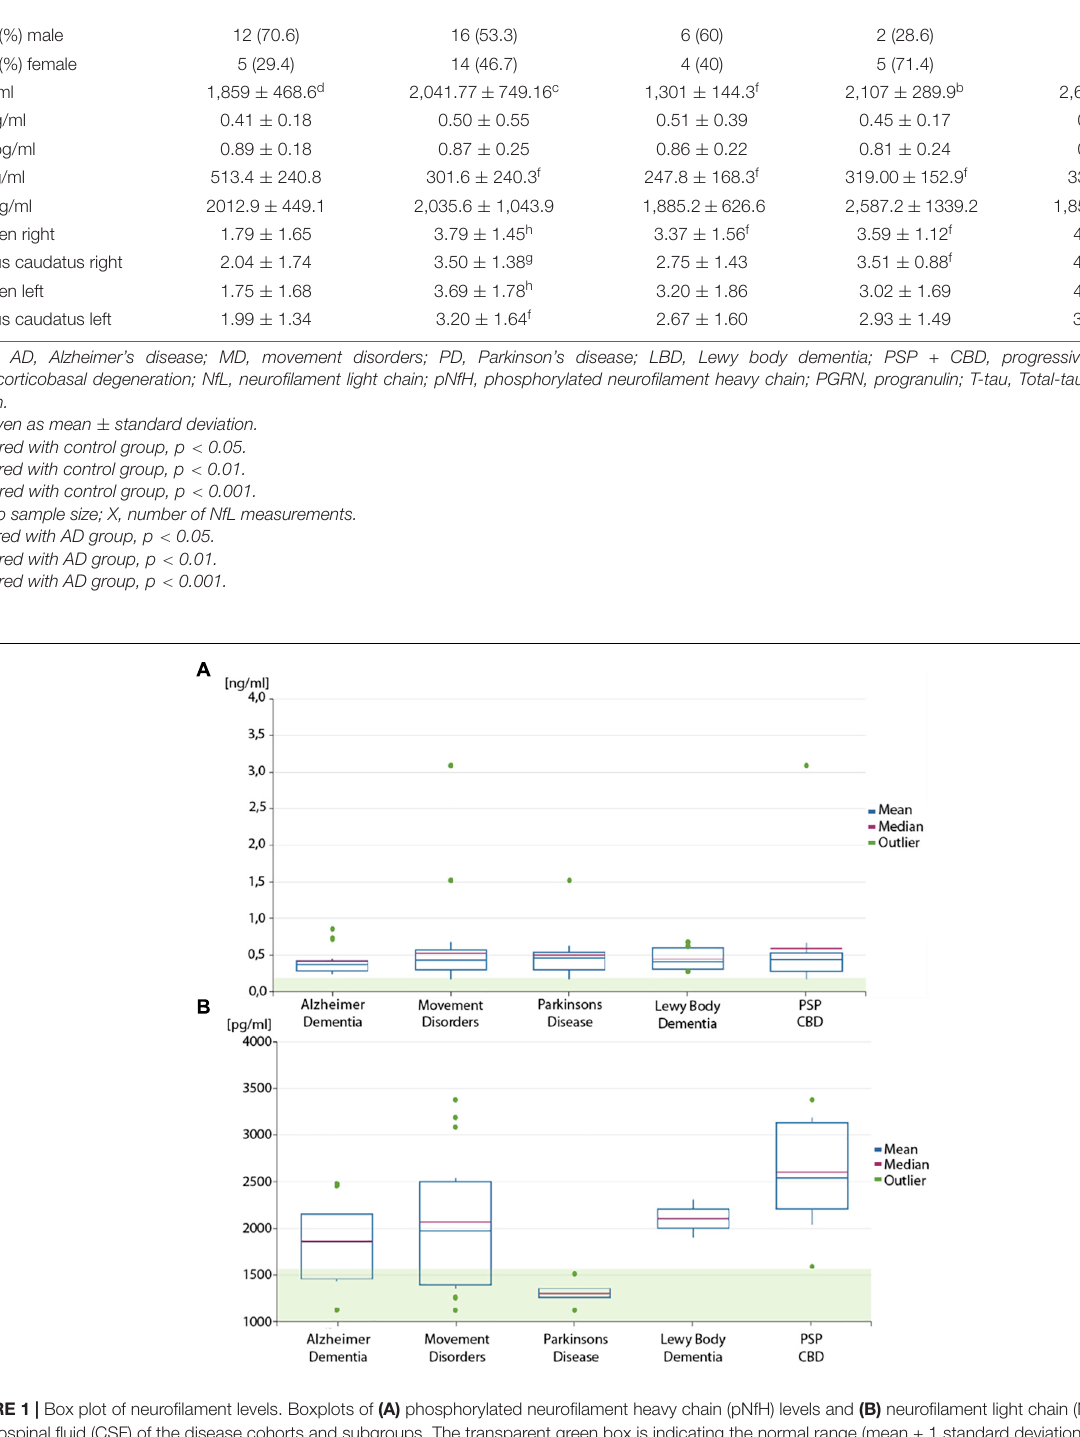
Frontiers in Neuroscience |